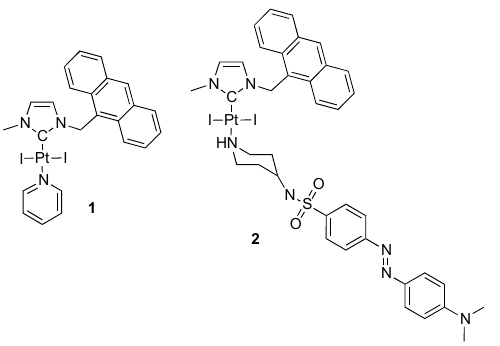
Figure 2. Molecular structure of the NHC platinum complexes used in this study.